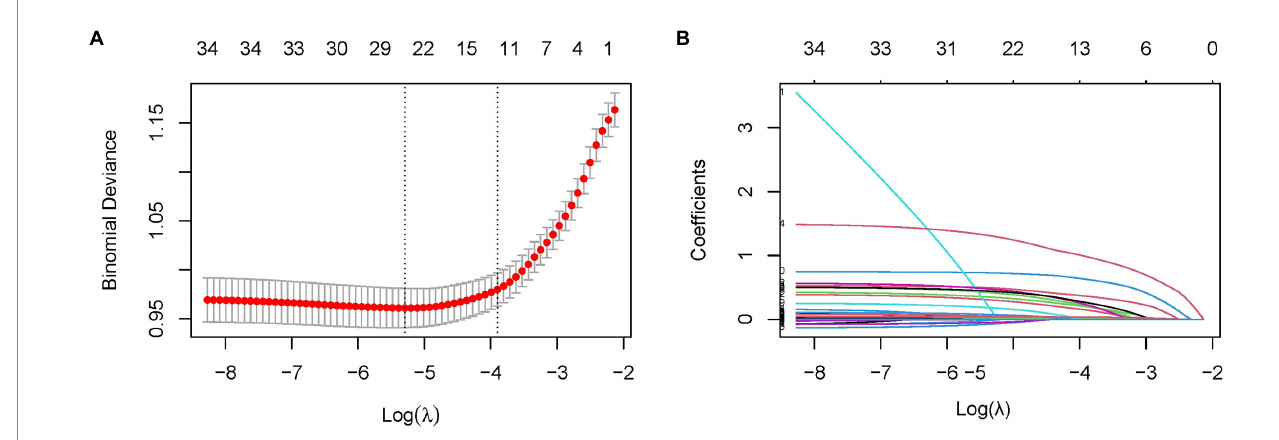
FIGURE 1 Predictor selection using the LASSO binary logistic regression model. (A) The tuning parameters (lambda) of the LASSO model were selected through 10- fold cross-validation using minimum criteria. A minimum criteria and a 1-SE criteria were used to draw the dotted vertical lines representing the optimal values. A lambda value of 0.016821, with log (lambda), 0.004167 was chosen (1-SE criteria) according to 10-fold cross-validation. (B) Profiling the 35 features by LASSO coefficients. Using log (lambda) sequences, a coefficient profile plot was generated. With 10-fold cross-validation, a vertical line was drawn at the value selected where optimal lambda resulted in 13 predictors with nonzero coefficients.